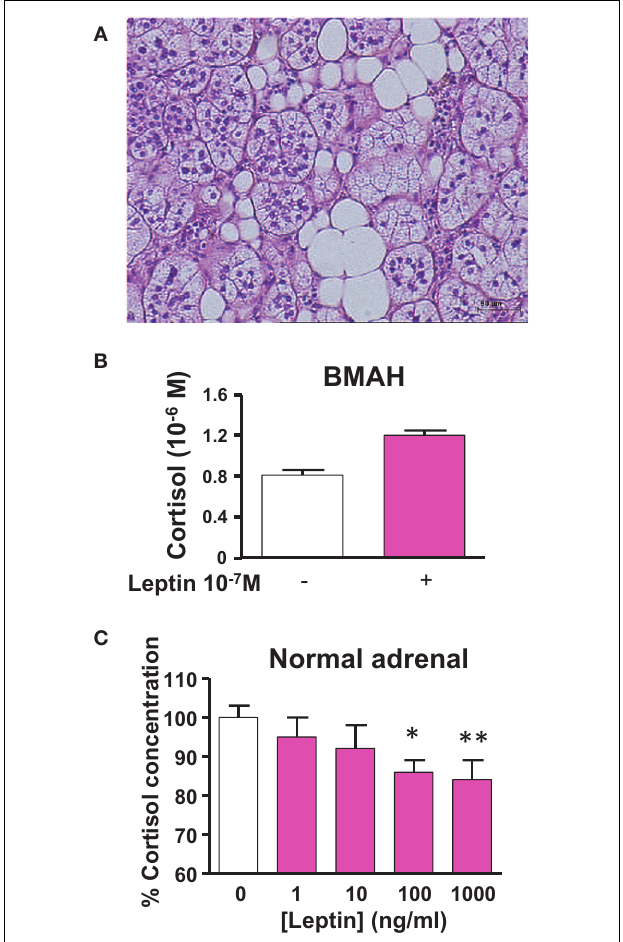
FIGURE 3 | Leptin pathway in bilateral macronodular adrenal hyperplasia (BMAH) associated with Cushing’s syndrome . (A) Islets of adipocytes in the vicinity of steroidogenic cells in BMAH tissue. (B) Abnormal stimulatory effect of leptin (10 − 7 M) on cortisol secretion by cultured adrenocortical cells derived from a BMAH tissue in a patient with Cushing’s syndrome ( p = 0.06). Adapted from Ref. (89). (C) Leptin reduces ACTH-induced cortisol secretion by cultured normal adrenocortical cells in a dose-dependent manner (* p < 0.01; ** p < 0.001). Adapted from Ref. (87).